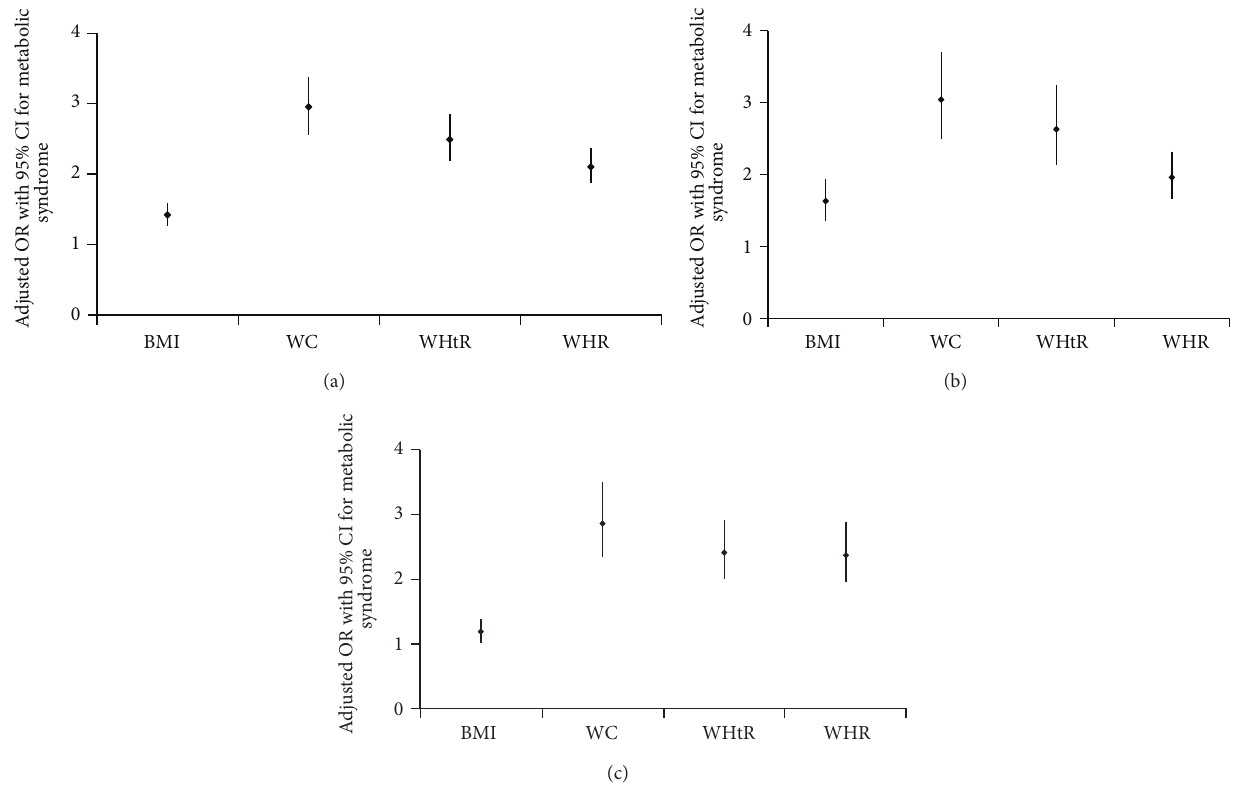
Figure 2: Adjusted odds ratios (adj. OR) for metabolic syndrome for one quartile increase in anthropometric variables in individuals. All the models are adjusted for age, education, smoking status, and family history of hypertension and diabetes. (a) Model for the general population, (b) model for females population, and (c) model for male population. BMI = Body Mass Index, WC = Waist Circumference, WHtR = Waist Height Ratio, and WHR = Waist Hip